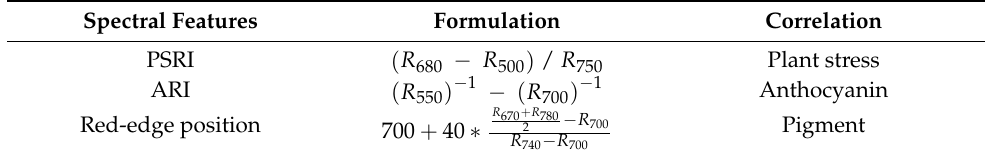
Table 2. Sensitive spectral